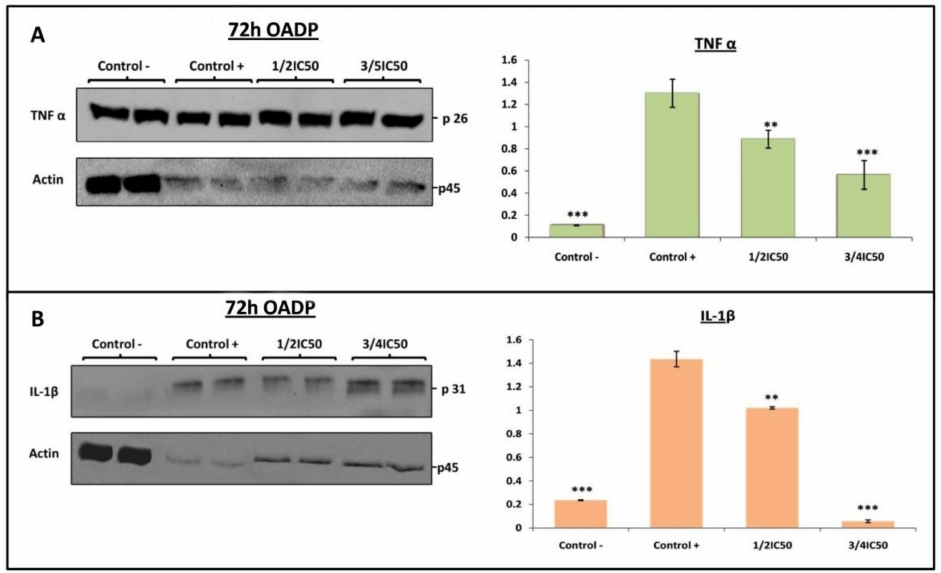
Figure 6. Western blot of the levels of TNF- α ( A ) (p26) and IL-1 β ( B ) (p31) proteins on LPS-stimulated Raw 264.7 cells, after treatment with OADP for 72h at the 1 expression levels are expressed as arbitrary intensity units for each band compared to arbitrary intensity units for actin (p45). Variations in the relative percentages of TNF- α and IL-1 β expression for each concentration are also shown. The values represent means ± S.D. of at least two sepa- rate experiments. Key: (**) p < 0.01 and (***) p < 0.001, with respect to LPS-treated control cells (positive